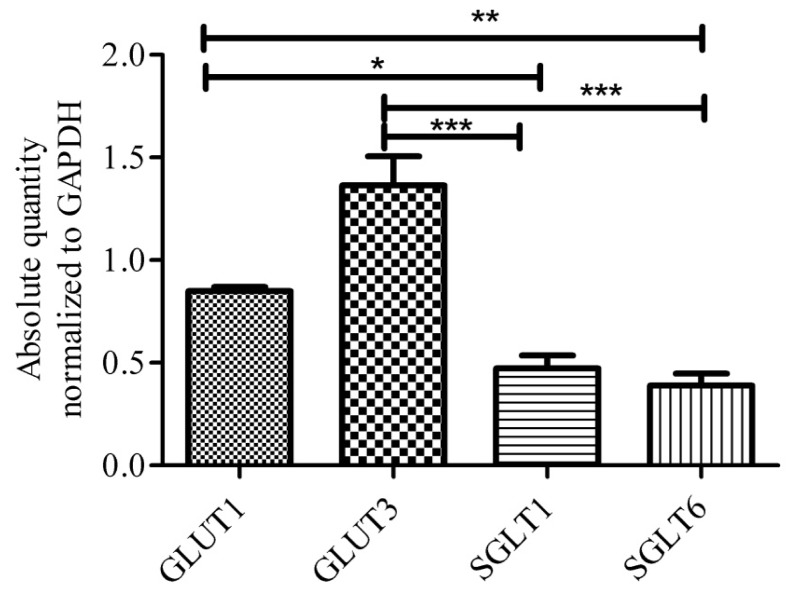
Expression of GLUT1, GLUT3, SGLT1 and SGLT6 mRNA of whole mouse brain tissues. Transcripts of glucose transporters per 0.75 μg of total RNA. Data shows normalized absolute quantity of transporter using qPCR SYBR technique. Data respresents mean ± SEM of 7–8 animals, analyzed using one way ANOVA test Post hoc Bonferroni’s Multiple comparison * p < 0.05, ** p < 0.01, *** p < 0.001.